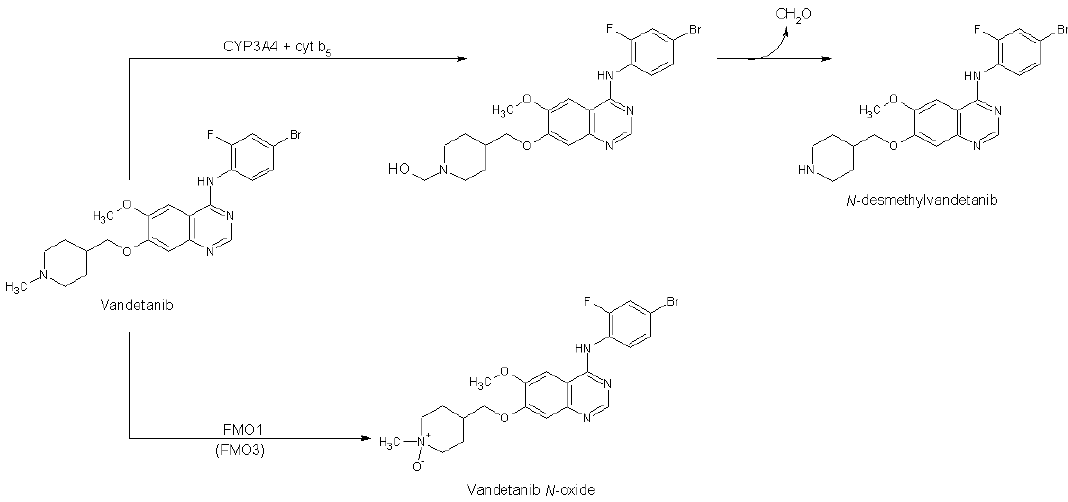
Figure 1. Vandetanib oxidation by CYP and FMO enzymes. Cytochrome b 5 (cyt b 5 ).